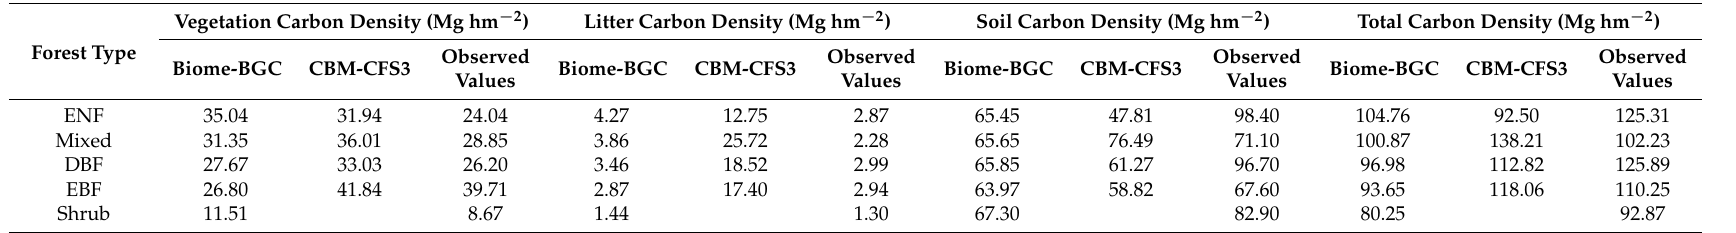
Table 4. Comparison of estimation results of carbon density for the main forest types in the